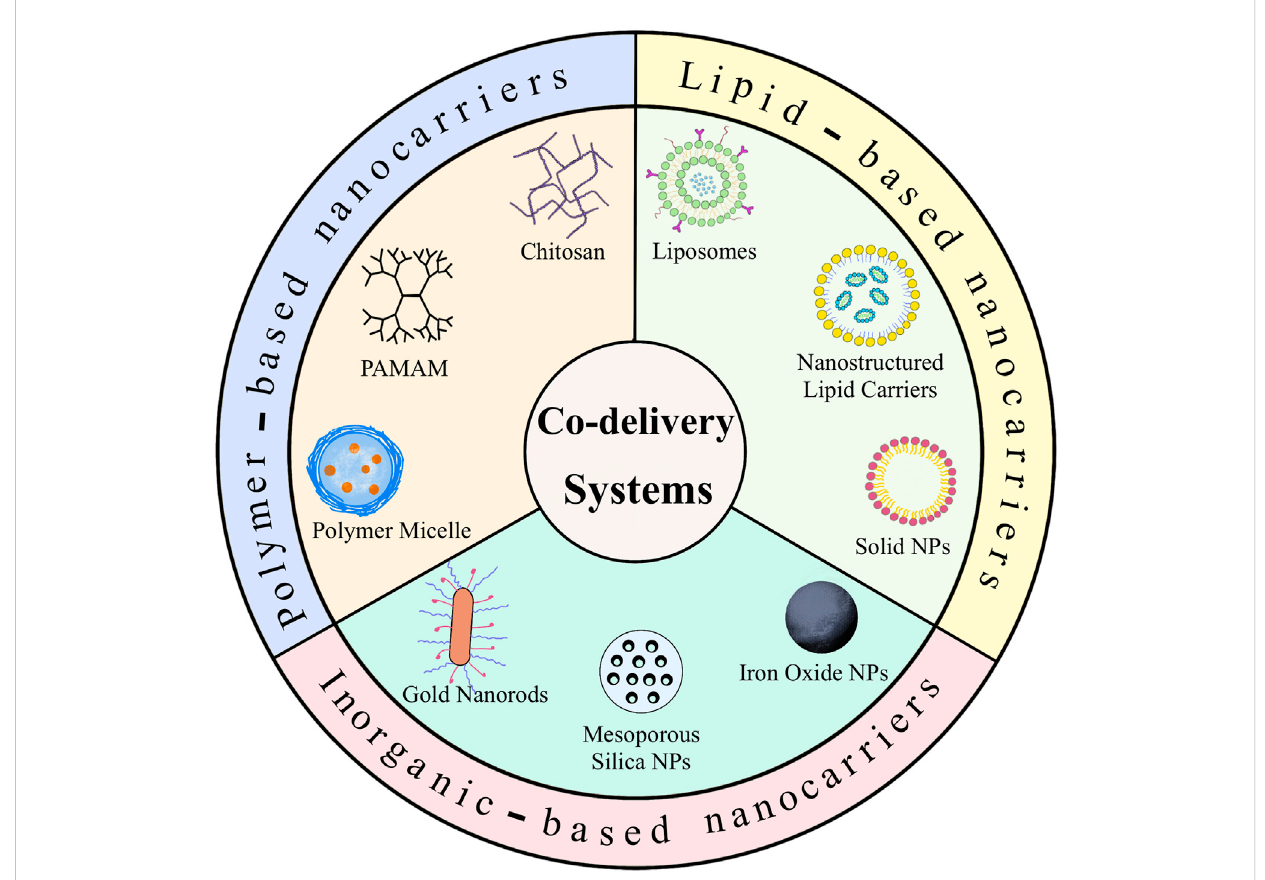
FIGURE 1 Schematic illustration of different nanocarriers for co-delivery of anticancer